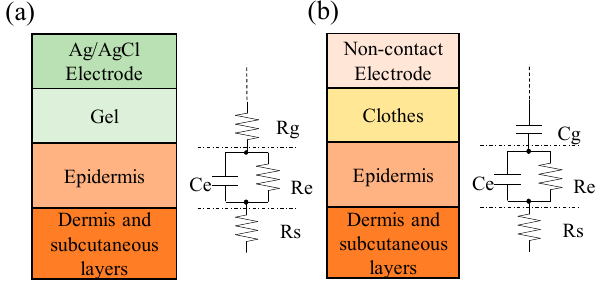
Figure 1. The skin-electrode interface models of ( a ) an Ag–AgCl electrode and ( b ) a noncontact dry electrode.